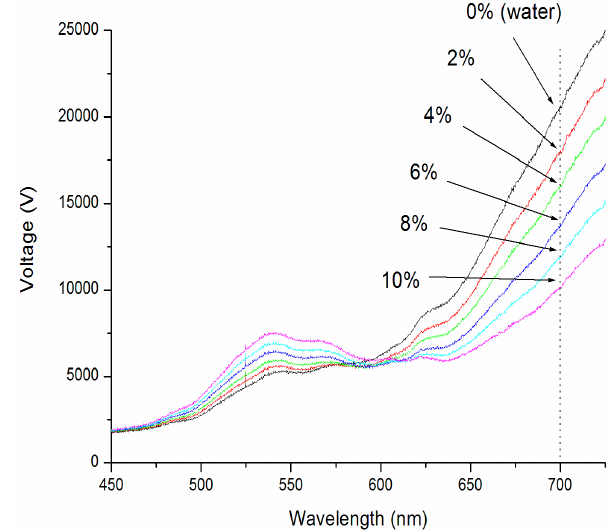
Figure 2. SPR spectra for salt (sodium chloride) solutions ranging from 0 to 10%, which corresponds to refractive index values between 1.3330–1.3504 RIU (refractive index unit).